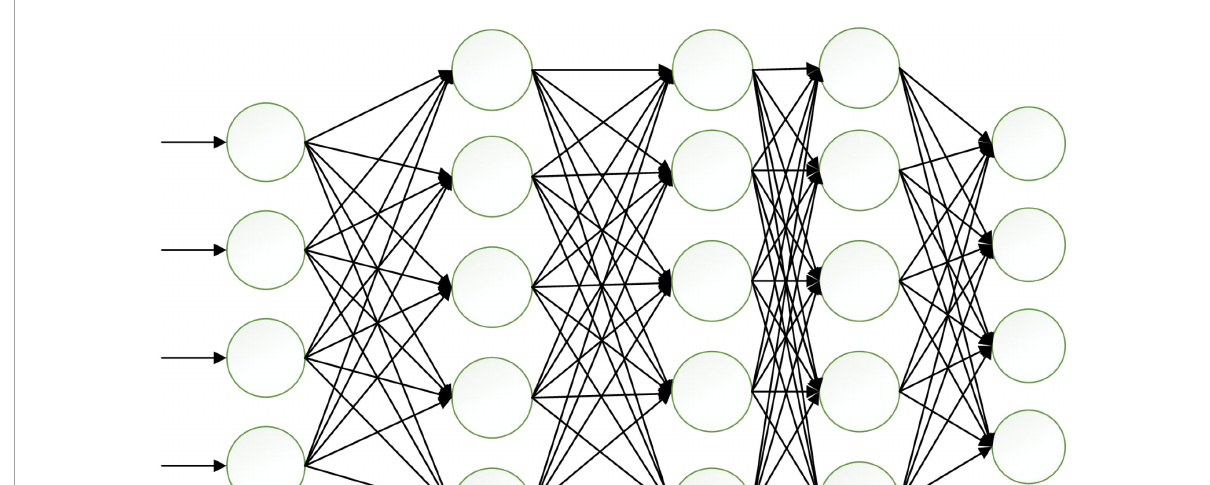
FIGURE6 Basic model diagram of intelligent emotional network.